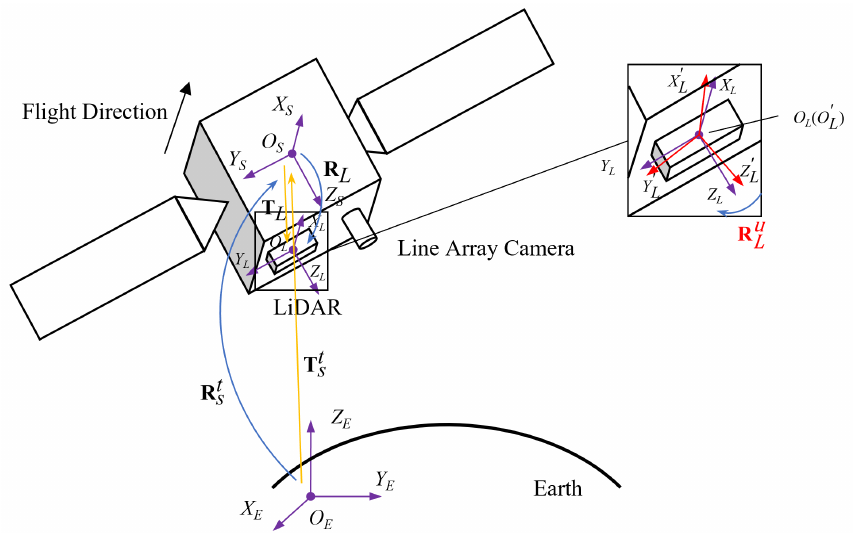
Figure 5. The geometric meaning of the matrices of the observation model of the